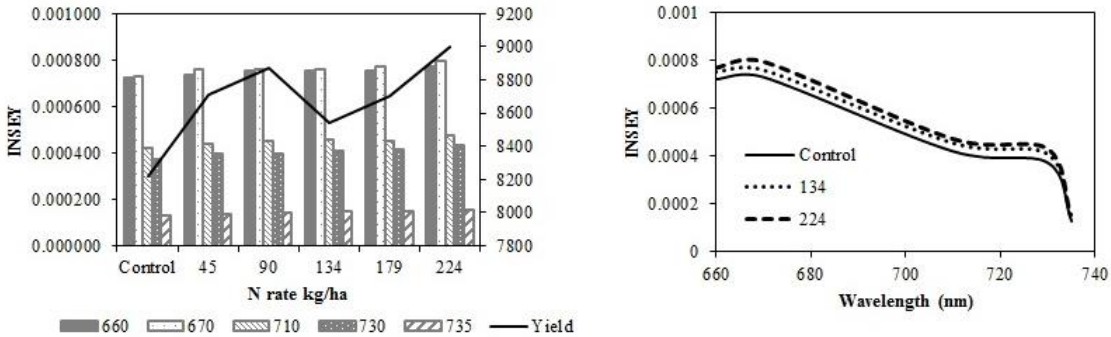
Figure 4. Variation of INSEY for corn at eastern no-till sites calculated from CC active-sensor spectra (670 and 730 nm) and GS spectra (660, 710 and 735 nm) with N rate compared to yield variation with N rate at V6 (upper left) and V12 (lower left) . Trend for INSEY at three N rates (control, 134 kg·ha −1 and 224 kg·ha −1 ) over the five wavelengths represented as a continuous spectrum is displayed at V6 (upper right) and at V12 (lower right) .